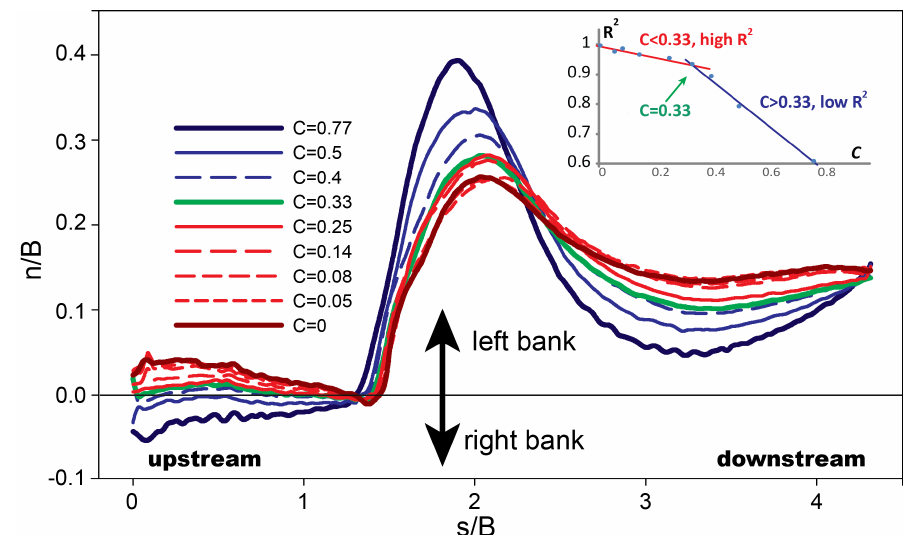
Figure 8. The first moment of normalized depth averaged streamwise velocity < v s > / U , which represents center of gravity of the streamwise flow distribution, along the channel. The inset shows the R 2 of the first moment of < v s > / U between each curvature and the straight channel condition ( C = 0, R 2 = 1); a lower R 2 suggests greater hydraulic complexity for the first moment of depth averaged streamwise